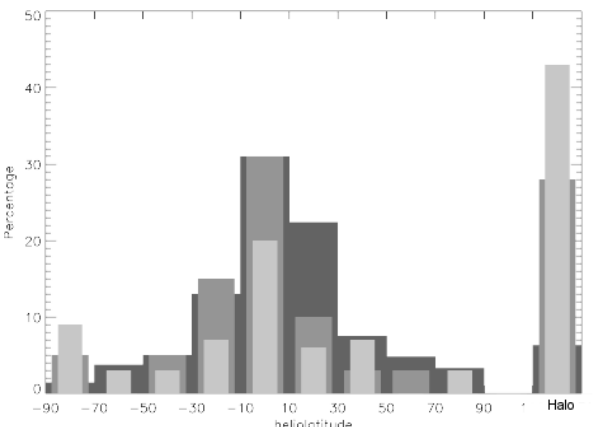
Fig. 7. In light grey: heliolatitude distribution for the CMEs iden- tified in column 7 of Table 1. In dark grey: same histogram for the CMEs identified in column 6 of Table 1. In black: same histogram for all the CMEs identified in LASCO during the same period.